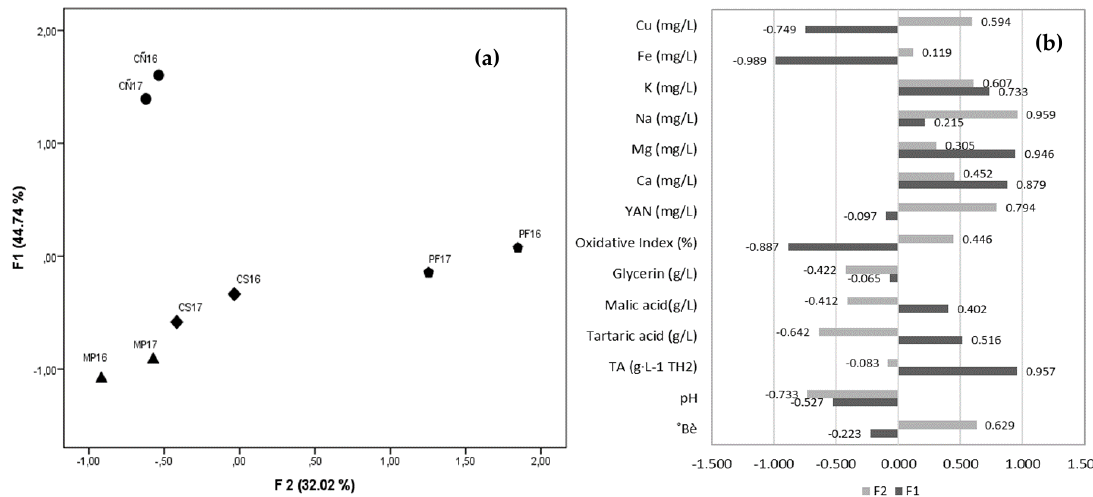
Figure 1. Principal component analysis ( a ) and its loading factors ( b ) of Cañocazo [CÑ], Castellano [CS], Mantúo de Pilas [MP], and Palomino Fino [PF] grape musts physicochemical analysis during two consecutive years (2016 and 2017).